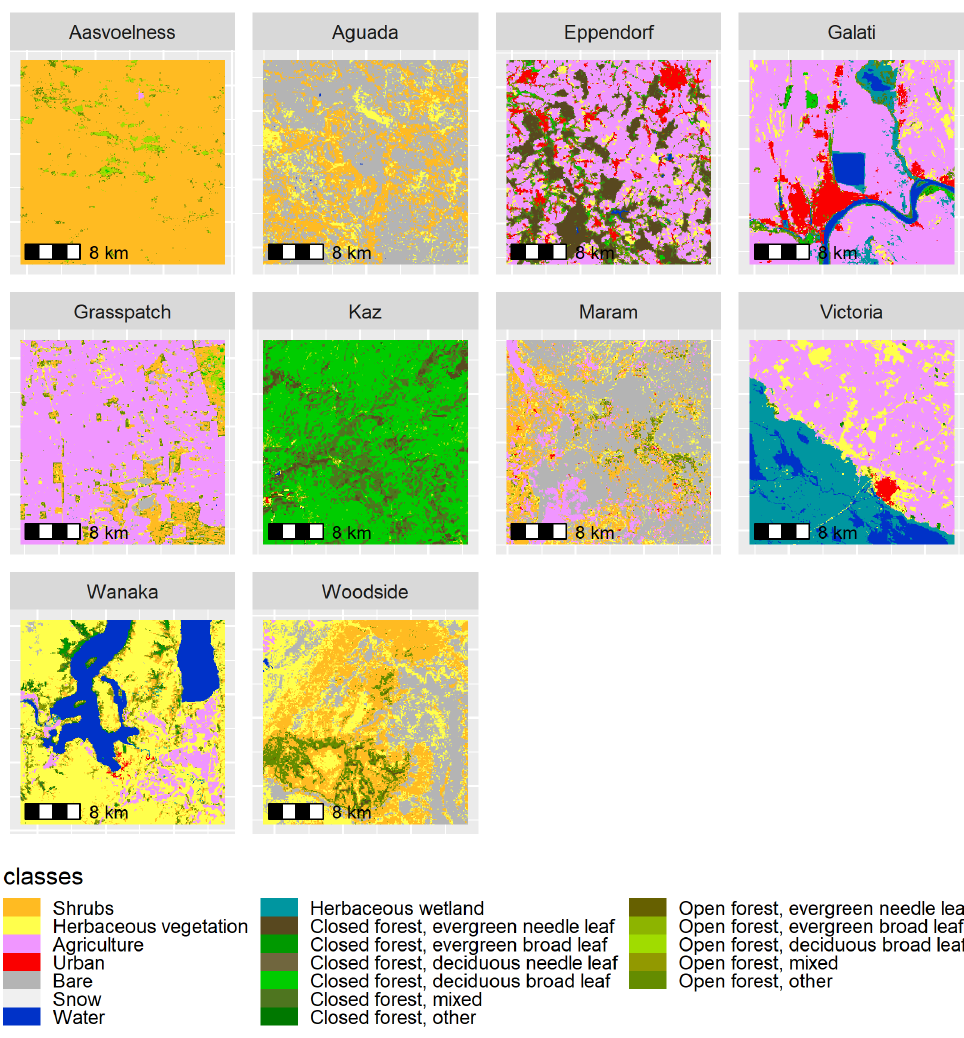
Figure 7. Copernicus land cover used as training labels for the random forest land cover processing algorithm. One hundred points were sampled on each dataset. Titles are